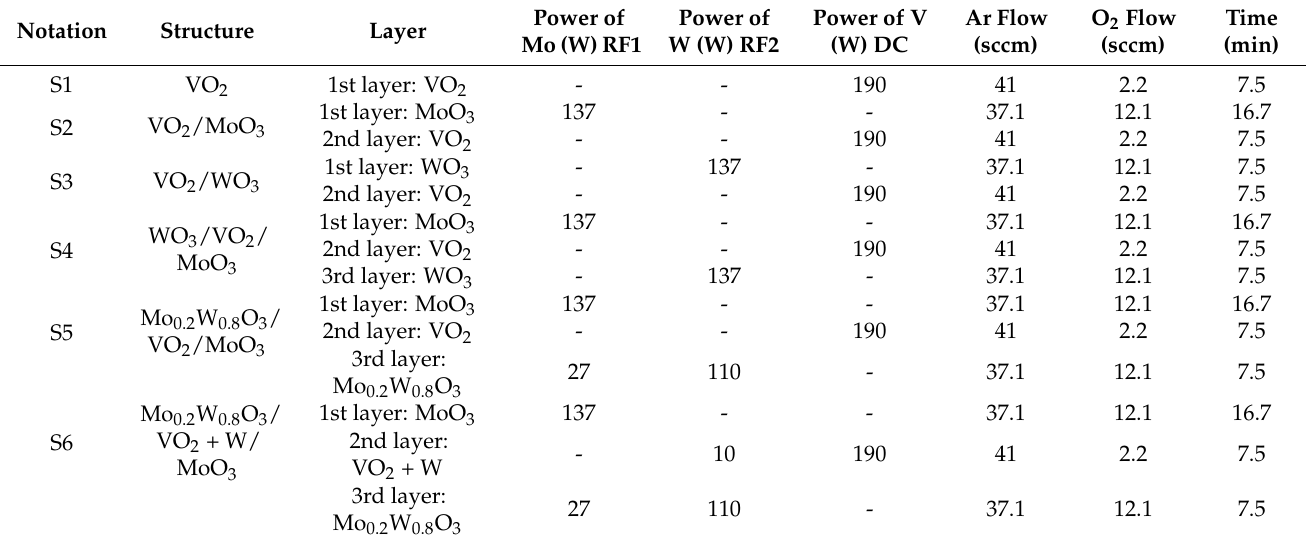
Table 1. Abbreviation of samples and deposition parameters of the multilayer